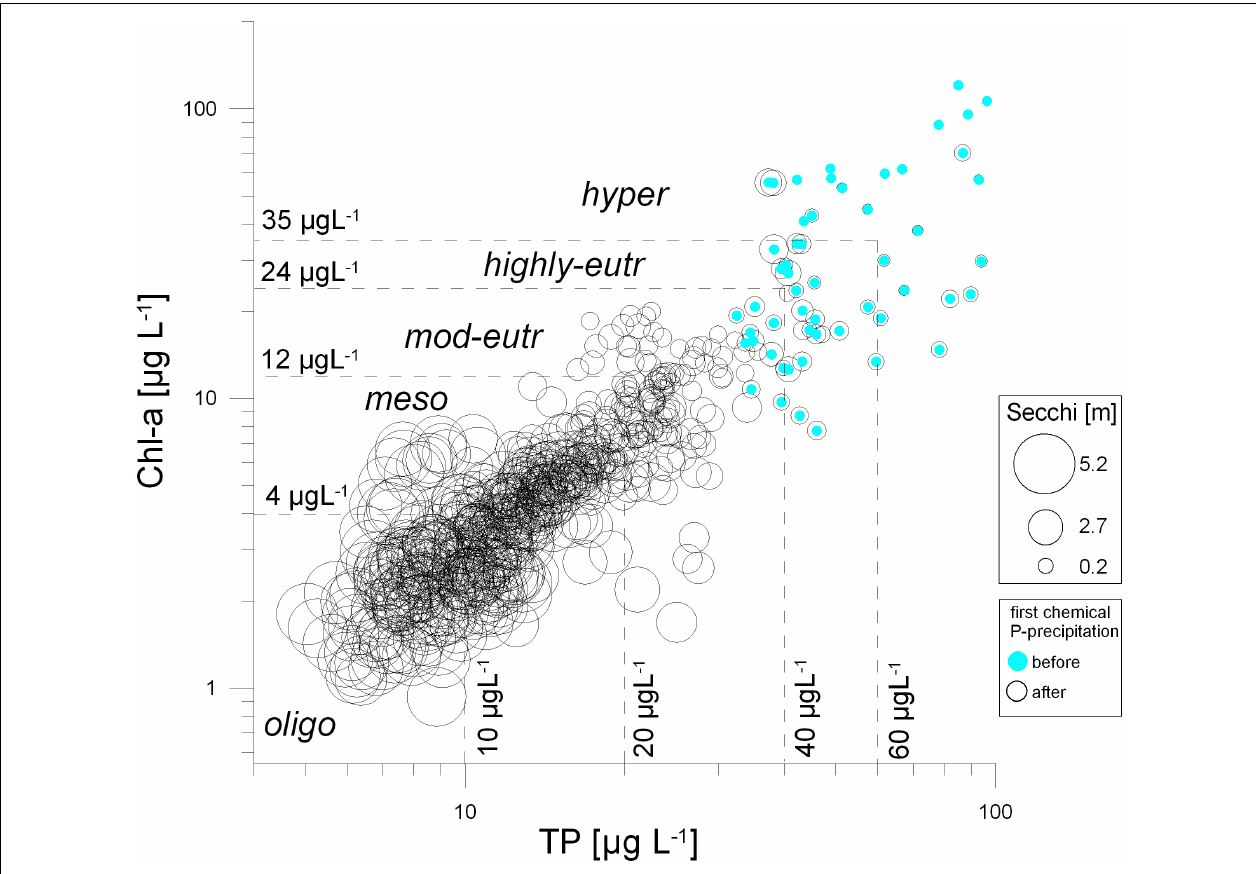
FIGURE 3 | Total phosphorus concentration (TP) versus algal biomass represented as Chlorophyll- a (Chl- a ). The size of the circles indicates the Secchi disk transparency [m] ranging between 0.26 and 5.23 m. The scatter plot is based on biweekly data from 1993 to 2019, blue points indicate the nutrient-rich period before phosphate precipitation started, from January 1993 to April 1995.